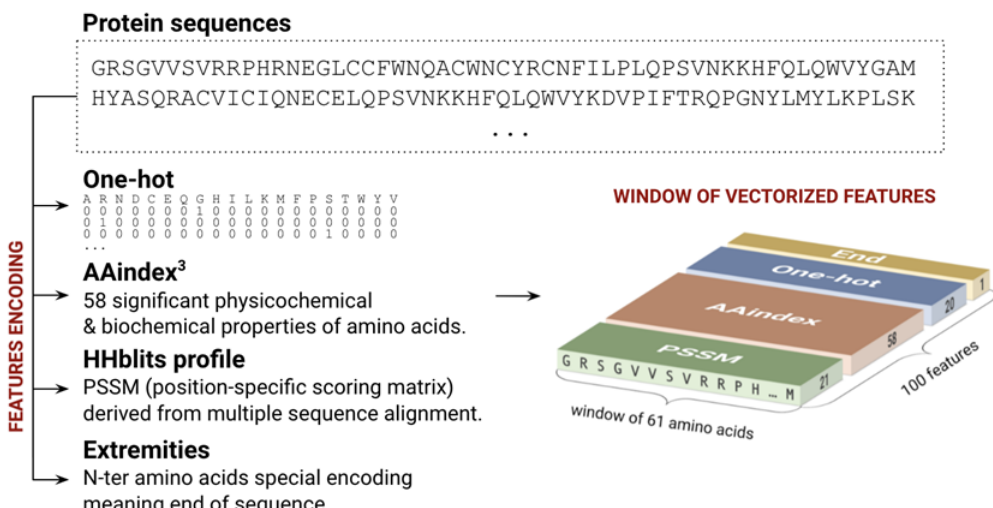
Figure 6. Sequence encoding used for prediction. We considered sequence fragments of 61 amino acids, each encoded by a vector of 100 features combining one-hot, AAindex, the PSSM profile, and the extremity flag.